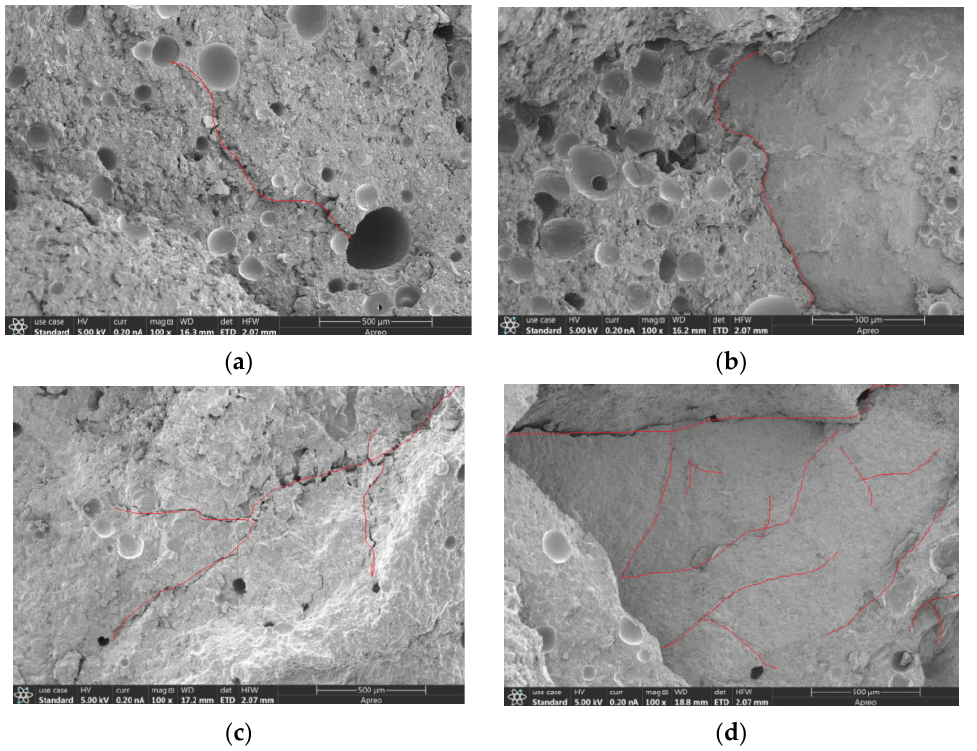
Figure 9. Microscopic form of 28-day cube specimen destruction. ( a ) Stage I (changes process from O to A); ( b ) Stage II (changes process from A to B); ( c ) Stage III (changes process from B to C); ( d ) Stage IV (changes process from C to D).